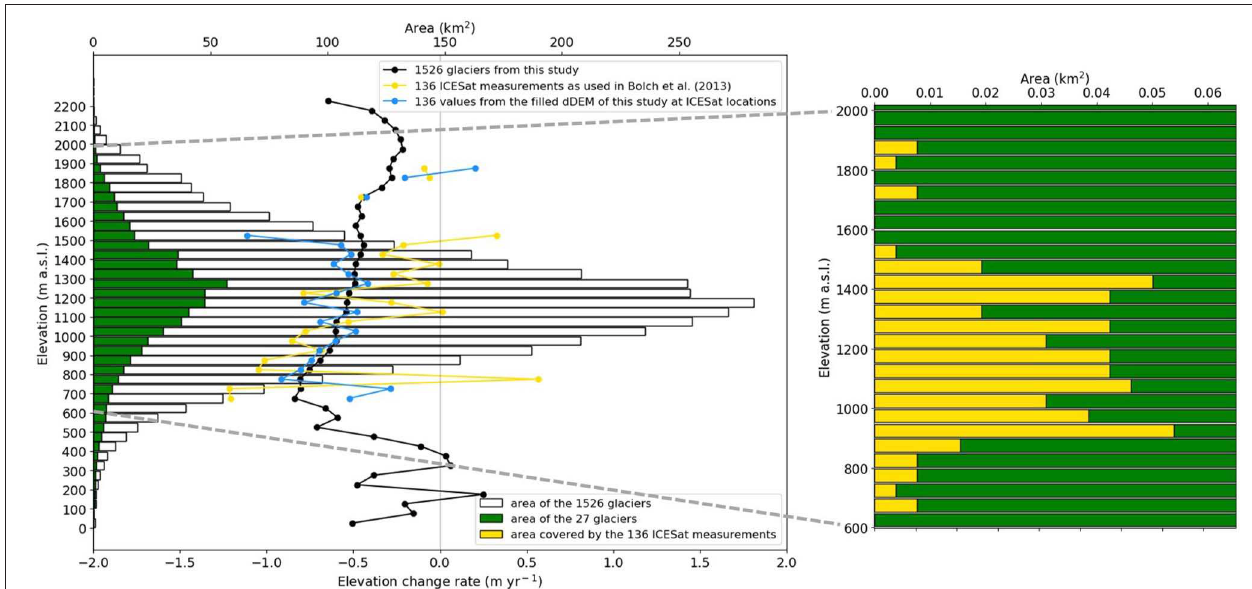
FIGURE 4 | Comparison of hypsometric elevation change rates between the present study and ICESat estimates from Bolch et al. (2013). The average elevation changes per elevation bin from this study, from the 136 ICESat estimates and from the 136 values from our change field at the ICESat locations are shown as black, yellow and blue lines, respectively. The bars represent the glacierized area with elevation covered by the 1,526 glaciers of this study (white), by the 27 glaciers that overlap between this study and the study of Bolch et al. (2013) (green), and by the 136 ICESat measurements (yellow). The latter is only visible when considerably zooming in as shown in the inset on the right (note the different scales for